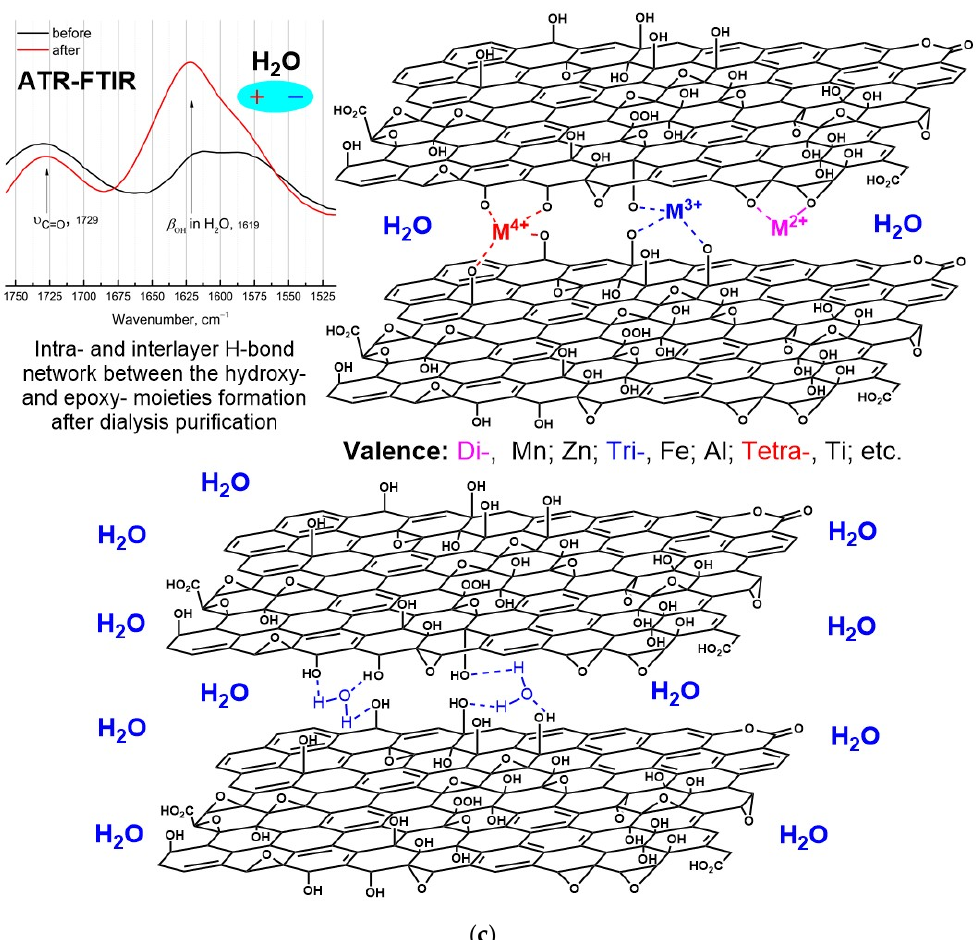
Figure 5. ATR-FTIR spectra of air-dried GO for as-prepared (black line) and after (red line) the dialysis process (3.5 kDa, MWCO). ( a ) Normalized ATR spectra in the range of 4000–100 cm − 1 . ( b ) Band assignments (in cm − 1 ). 128 spectra and background scans, 1 cm − 1 resolution. ( c ) Schematic illustration of the structure and bonds network changes after dialysis purification.